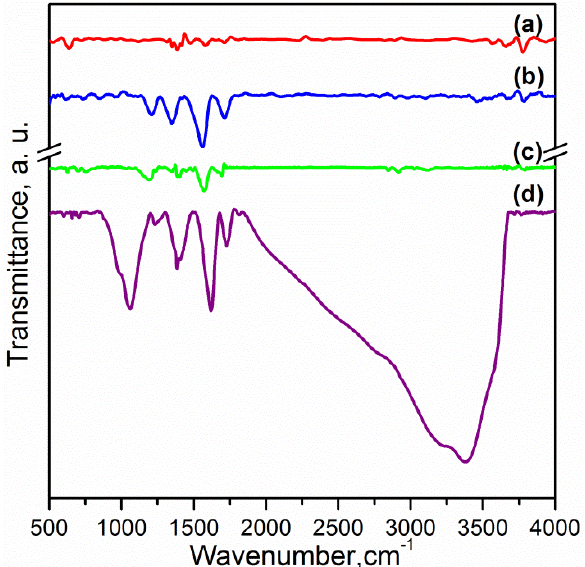
Figure 1. Fourier transform infrared spectroscopy (FTIR) spectra of: ( a ) Carbon nanotubes (CNTs); ( b ) oxidised carbon nanotubes (OCNTs); ( c ) reduced graphene oxide (RGO) and ( d ) graphene oxide